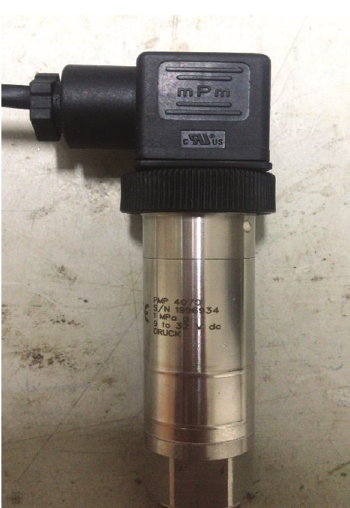
Figure 12: Absolute pressure sensor.